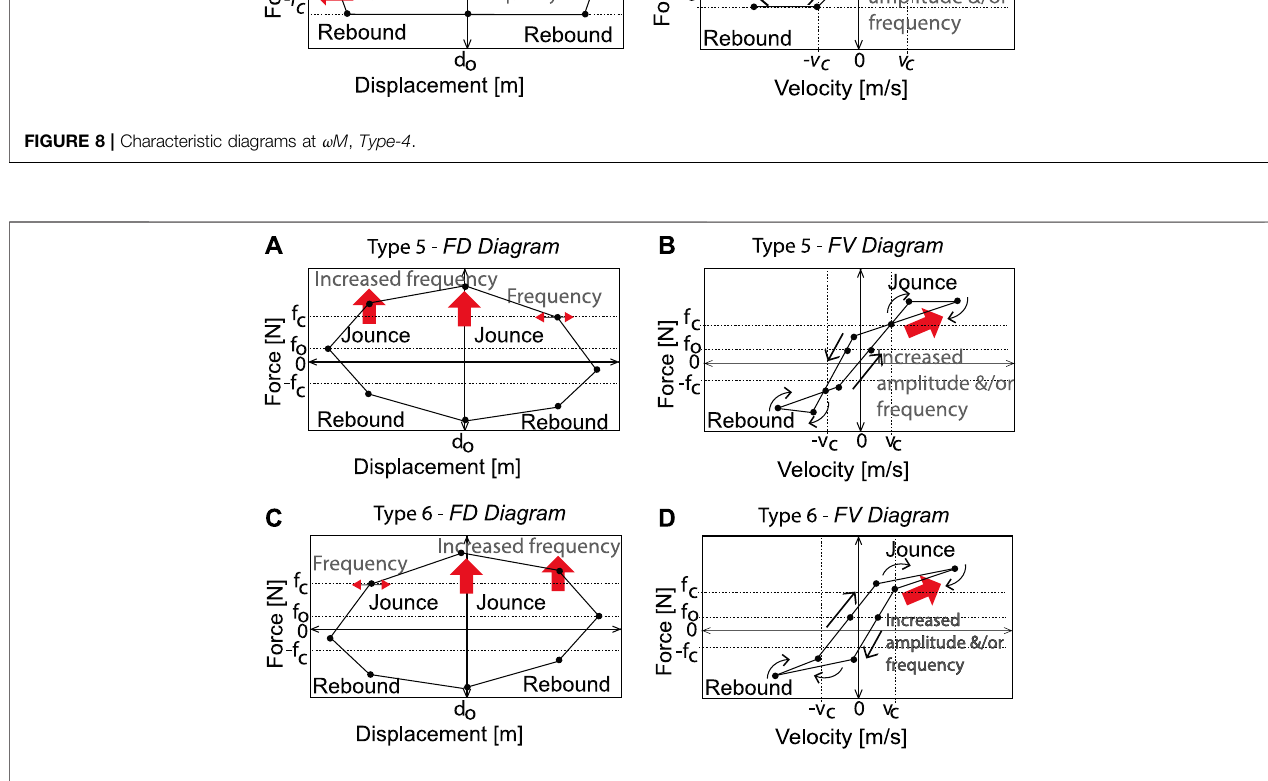
FIGURE 9 | Characteristic diagrams at ω A , Type-5 and Type-6